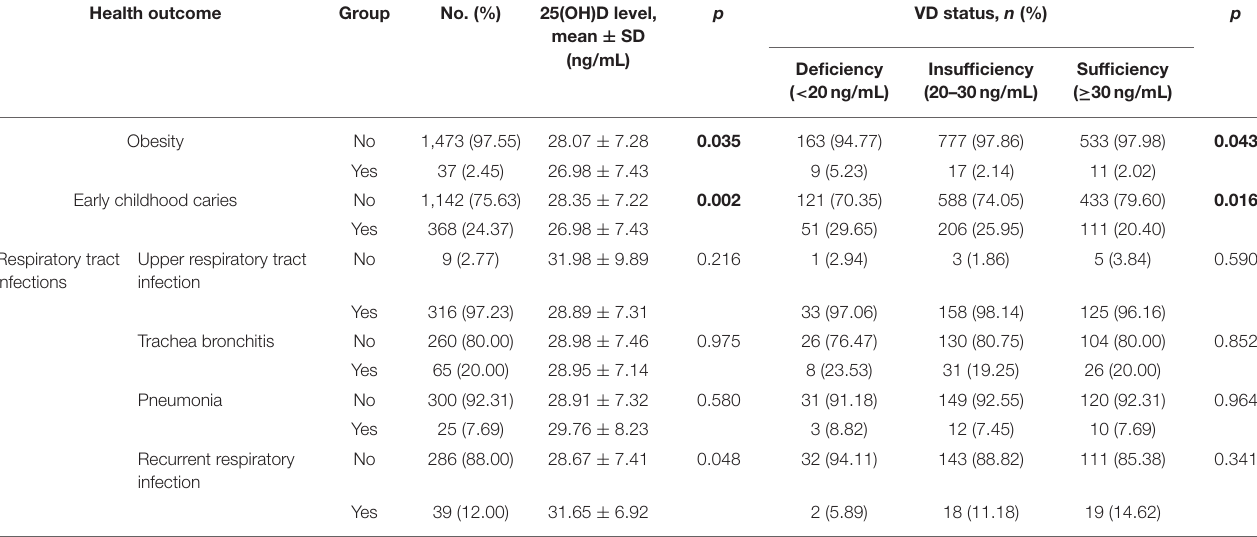
TABLE 2 | Correlation of serum 25(OH)D level/vitamin D status and related health outcomes. Health outcome